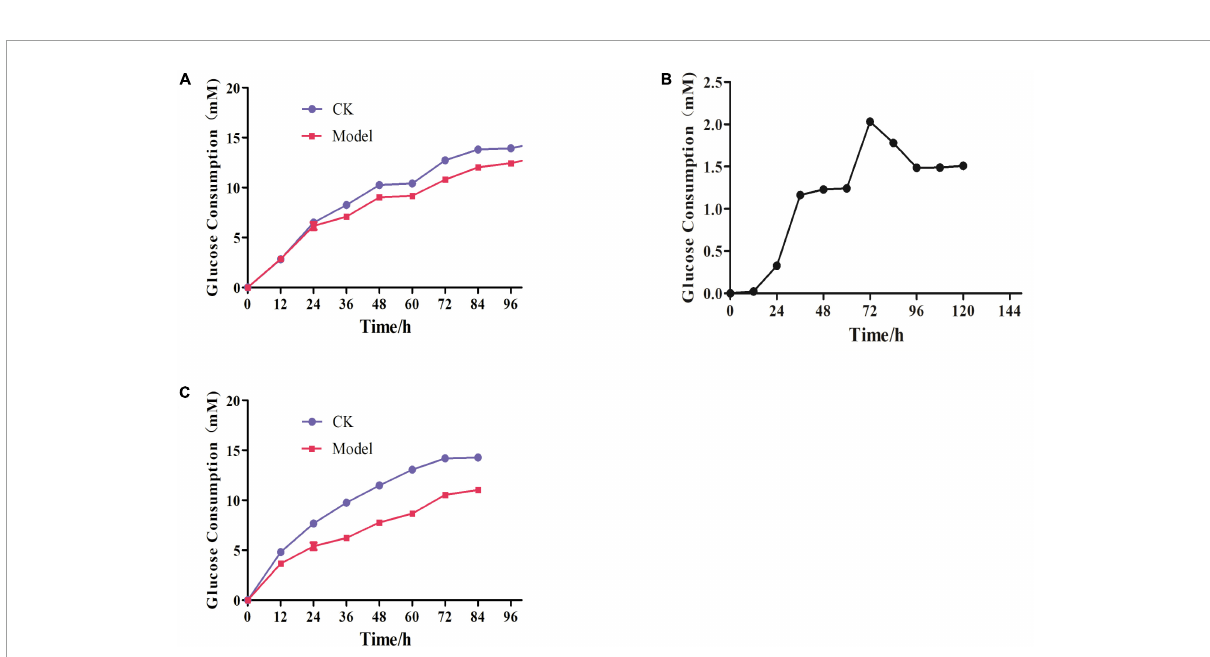
FIGURE6 Establishment of IR-3T3-L1 adipocyte model. (A) Glucose consumption test during insulin resistance induced by Dex; (B) dex induced insulin resistance in adipocytes glucose consumption difference; (C) Stability of insulin resistance model.